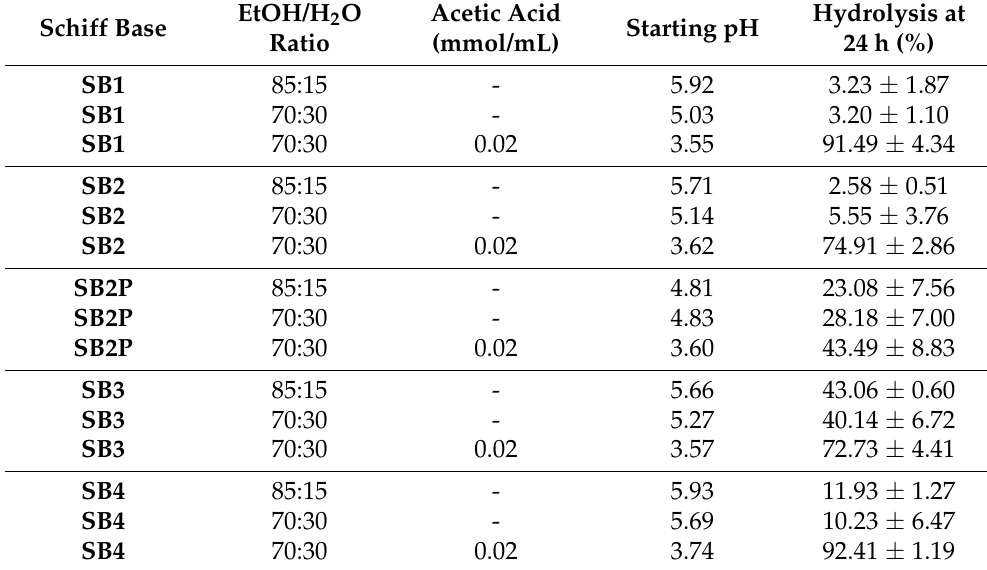
(Table 2), as acidic conditions are known to favor the hydrolysis of Schiff bases. Table 2. Hydrolysis of SB after 24 h in ethanol/water mixtures reported as mean value and stan- dard